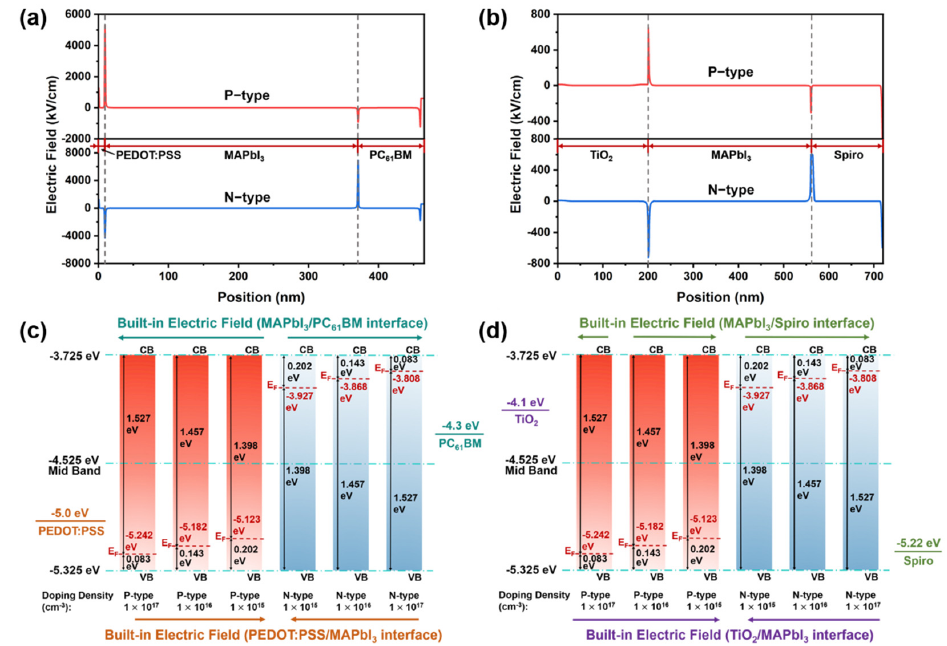
Figure 4. Built-in electric field distribution under P-doped and N-doped in ( a ) inverted and ( b ) regular photodiodes. The dashed grey lines are used to identify the layers in the devices from ( a ) to ( b ). Images of the interfacial E strength at ( c ) PEDOT:PSS/MAPbI 3 and MAPbI 3 /PC 61 BM interfaces, ( d ) TiO 2 /MAPbI 3 and MAPbI 3 /Spiro interfaces under different doping densities.